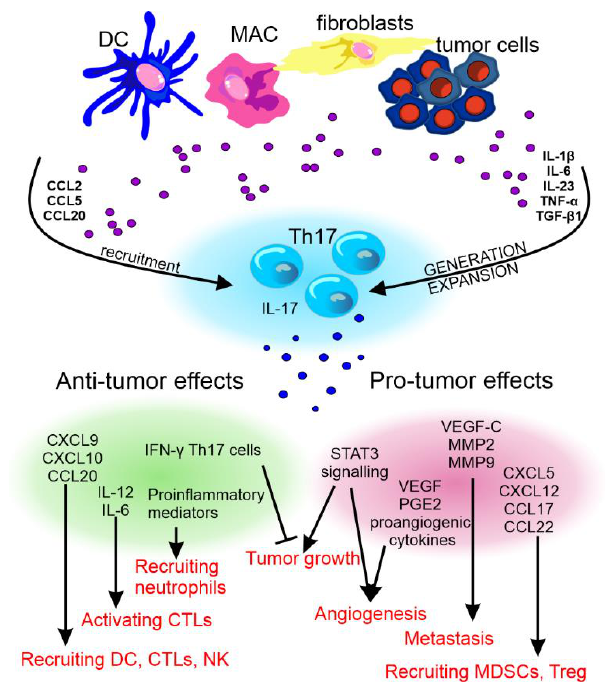
Figure 4. The anti- and pro-tumor effects of Th17 cells. The recruitment and differentiation of Th17 cells in the tumor environment is influenced by factors produced by dendritic cells (DCs), macro- phages (MAC), fibroblasts, and cancer cells. Th17 cells differentiated in this way may show